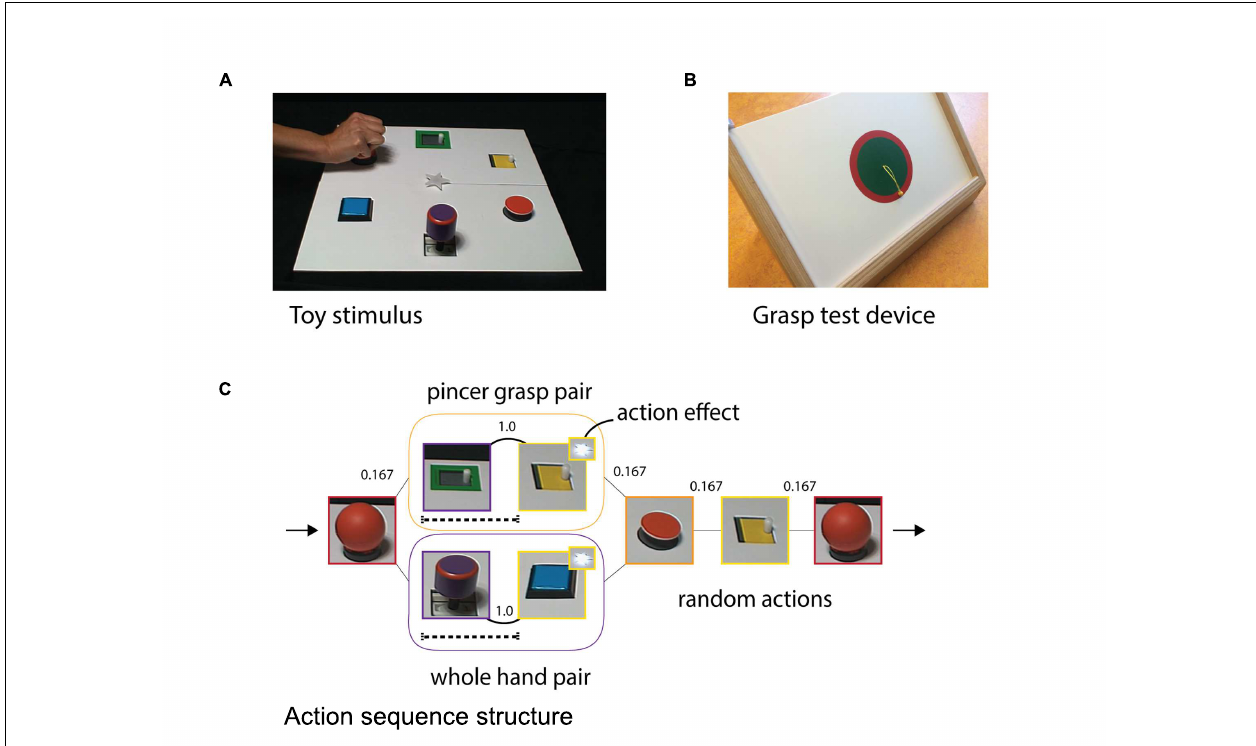
FIGURE 1 | (A) Example frame from the video stimuli, in which an adult performed a continuous sequence of actions with the six possible objects on the toy. (B) Following observation, infants’ grasping abilities were assessed using the pictured apparatus, which required them to extract the bead from the wooden board. (C) Schematic illustrating the statistical structure of the action sequence containing two deterministic pairs that caused a light effect: one pair was performed with a pincer grasp and the second with a whole-hand grasp. Numbers represent transitional probabilities between paired and random actions. Dotted lines underneath the first action of a pair depict the 4 second period preceding the target actions in which predictive gaze fixations were analyzed.